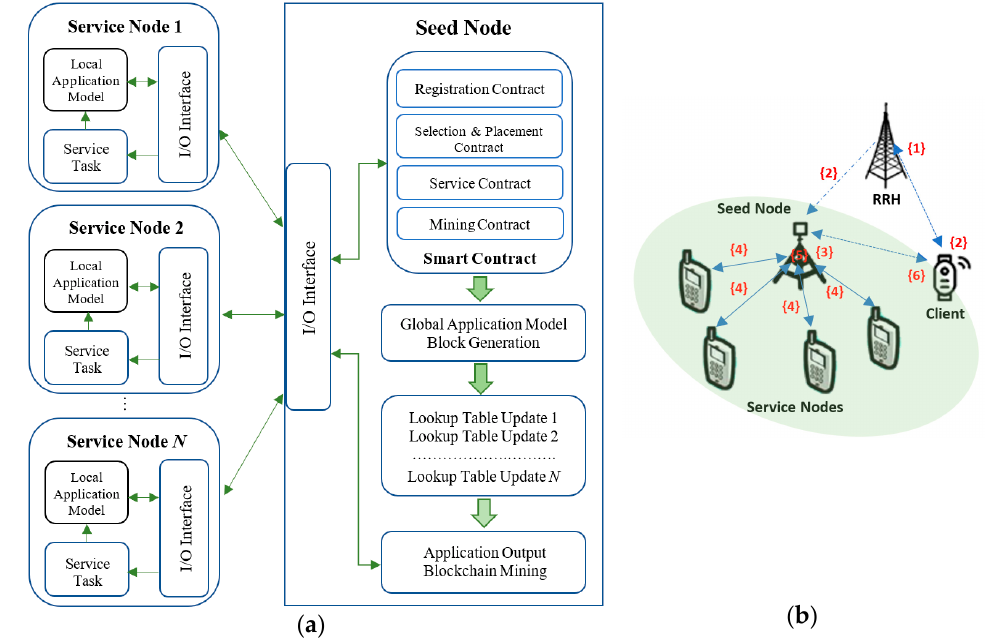
Figure 2. ( a ) System model; ( b ) Sequence of operations.